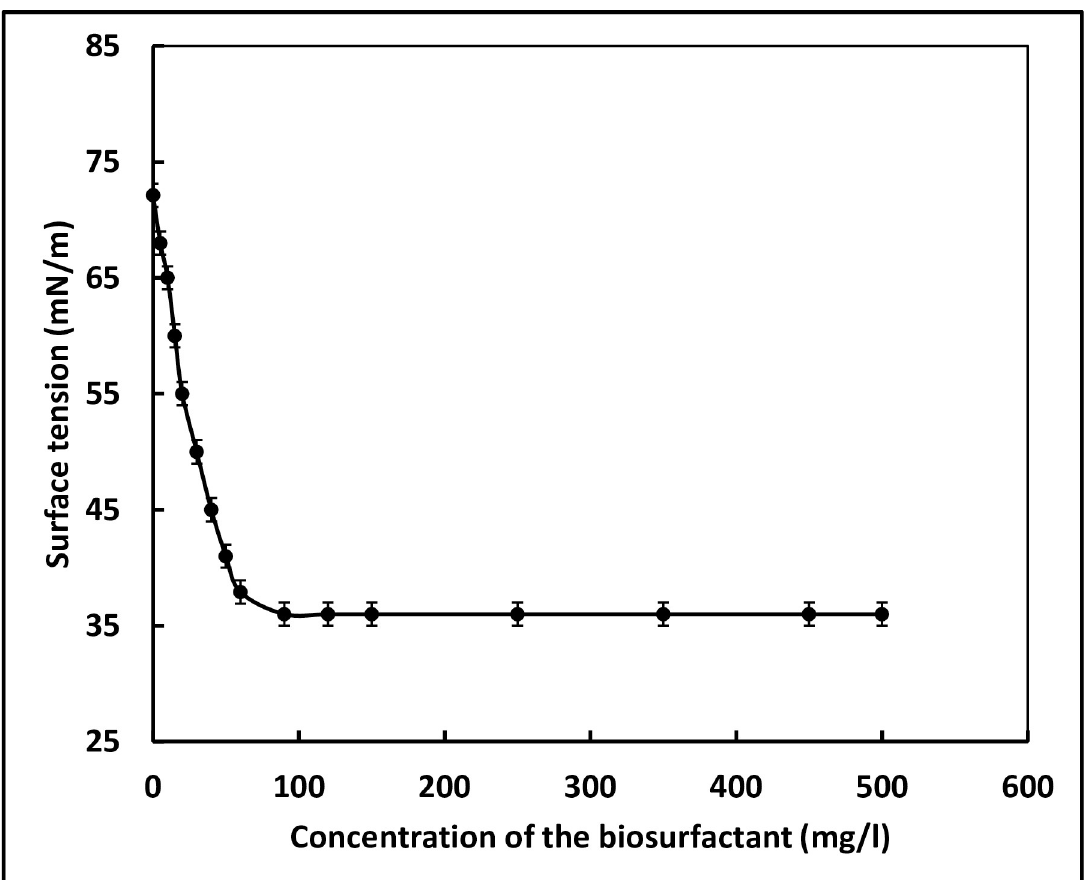
Fig 4. Critical micelle concentration of the